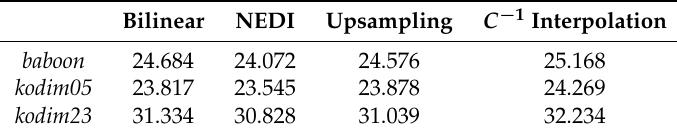
Table 1. Peak signal-to-noise ratio (PSNR) values.